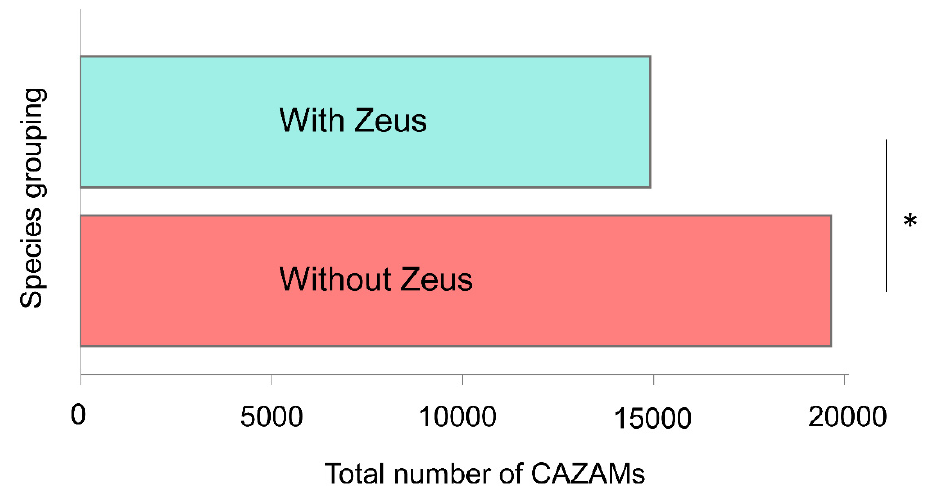
Figure 3. CAZAM frequency varies between species that possess and do not possess Zeus . Bar plot showing the mean frequency of the CAZAM in species with (top bar) and without (bottom bar) the Zeus duplication. The frequency of the CAZAM is significantly lower in species with Zeus (* p < 0.01).